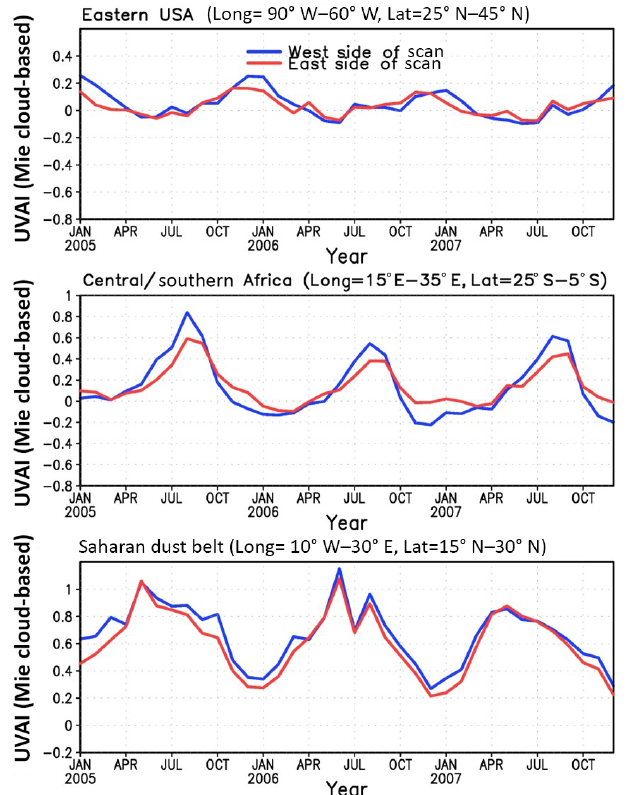
Figure 11. As in Fig. 6 using the Mie UVAI definition.